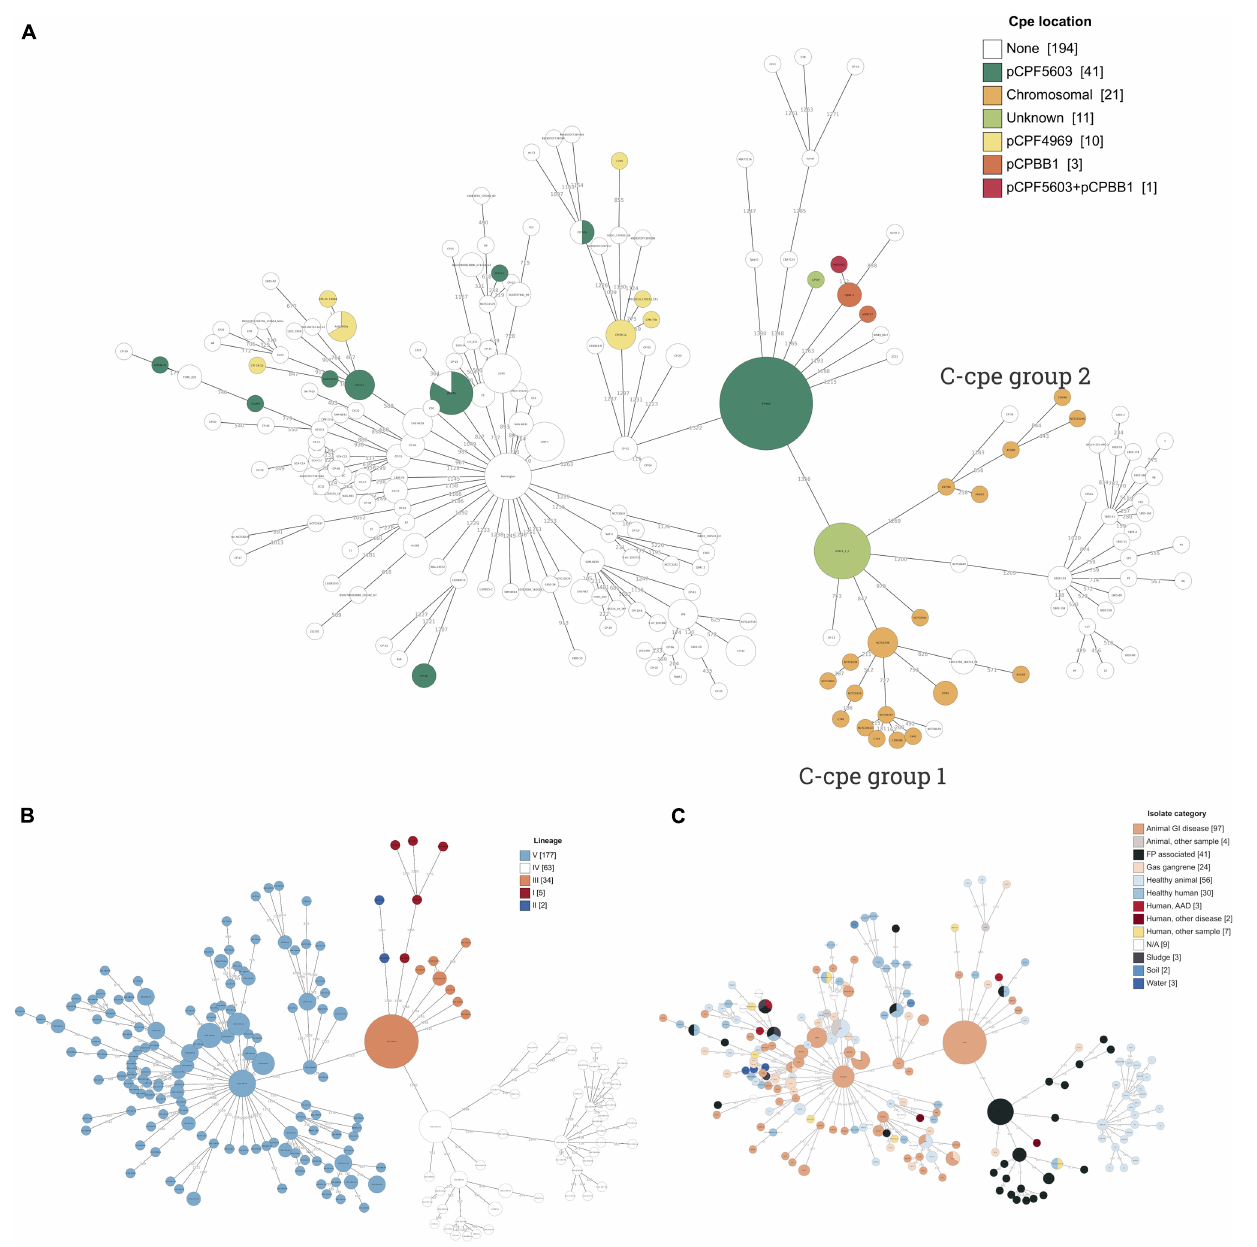
FIGURE 1 | A minimal spanning tree of Clostridium perfringens strains based on cgMLST (scheme by Abdel-Glil, 2019) results annotated with (A) cpe location, (B) lineages I–V (Feng et al., 2020), and (C) isolate category based on their isolation source. Branches with a distance of less than 100 are collapsed. Plasmid pCPF5603 was widely distributed phylogenetically and present in two lineages, III and V. Contrastingly, pCPF4969 plasmids were present in two branches of lineage V. Lineage IV included 32 cpe -negative strains together with the food poisoning-related isolates with cpe gene inserted in their